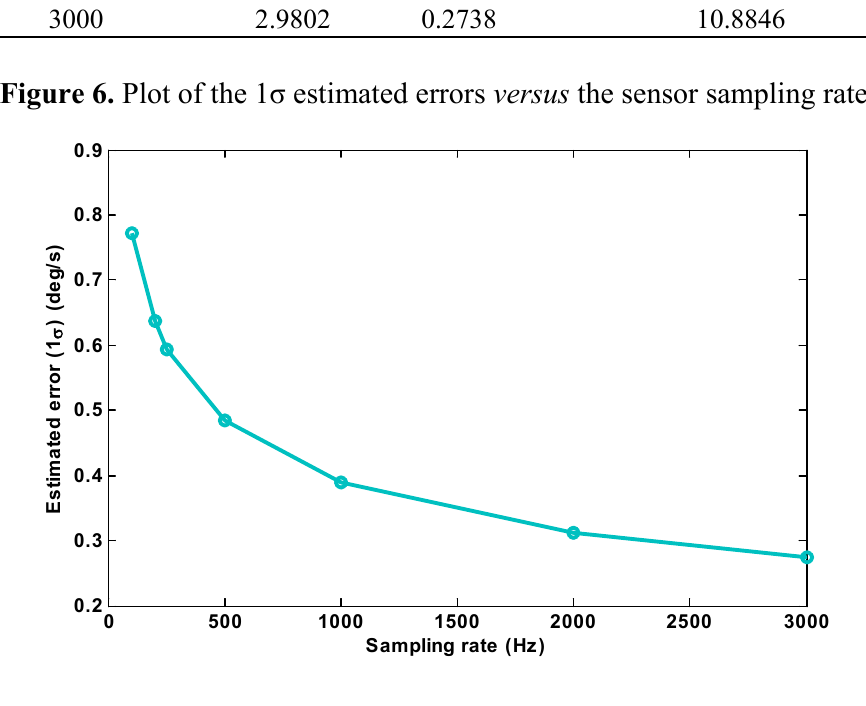
Table 2. Simulation results of virtual gyroscope with different sampling rates. Estimated error 1σ (°/s) Sampling rate f s (Hz)